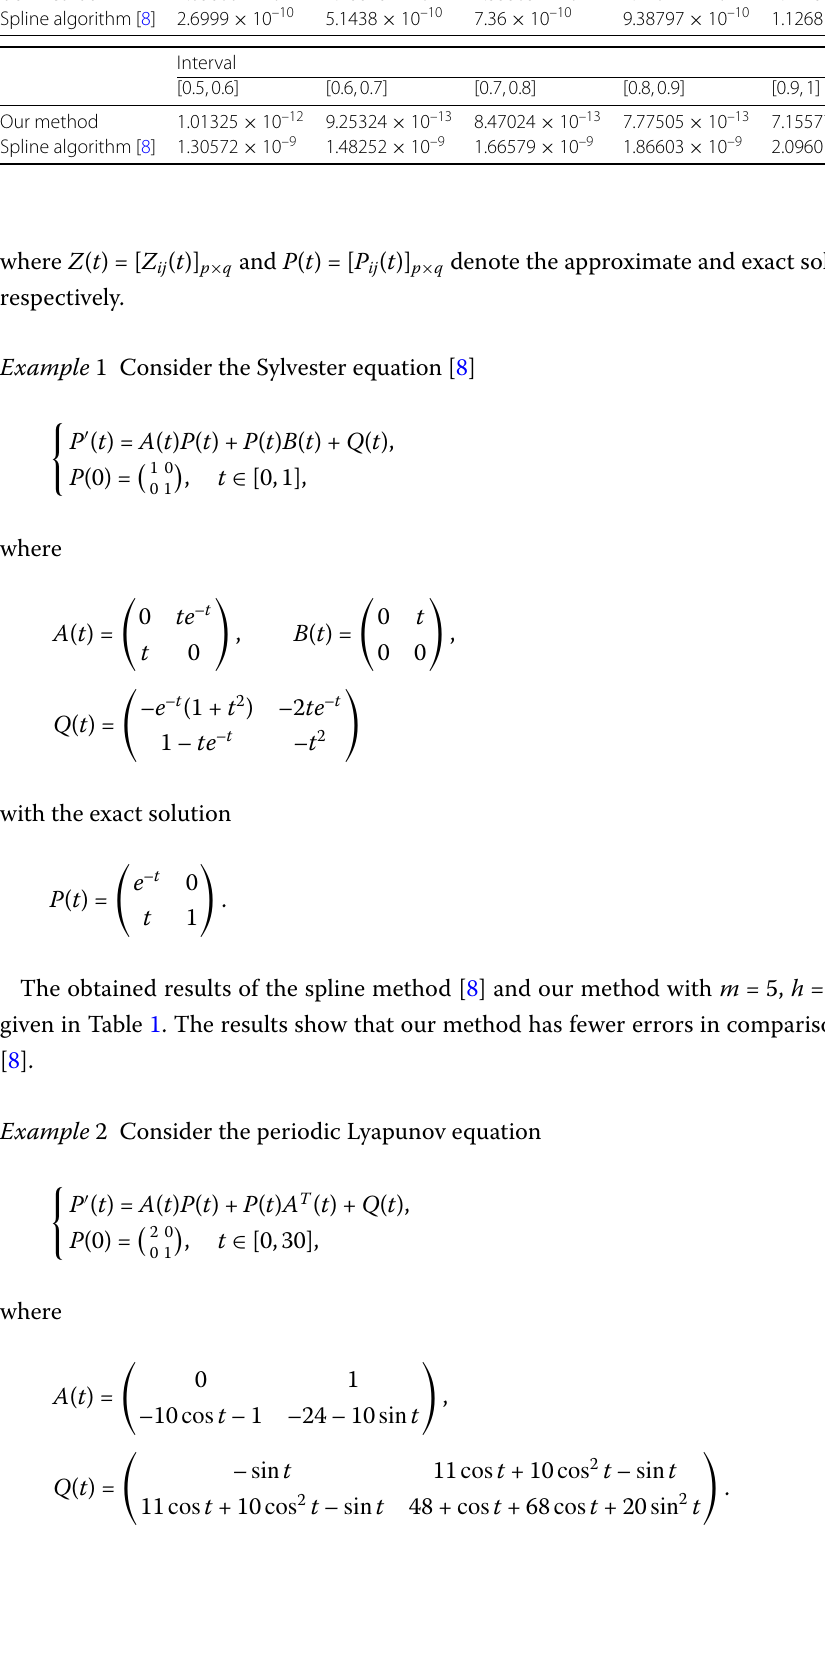
Table 1 Err comparison of the spline method [8] and the proposed method for equations (21)–(22) Interval